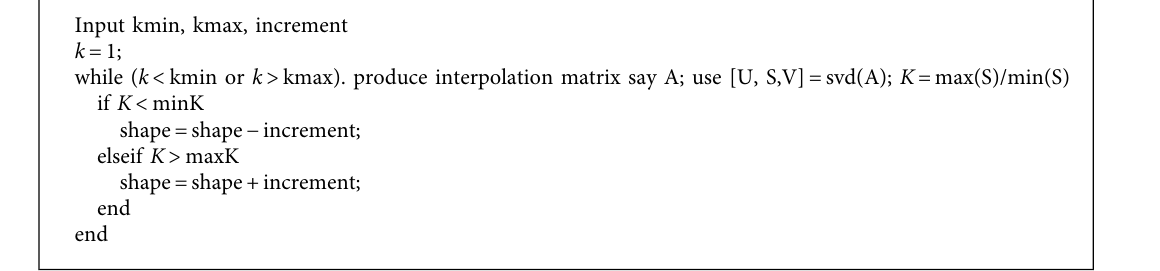
Table 1: Maximum absolute L Time